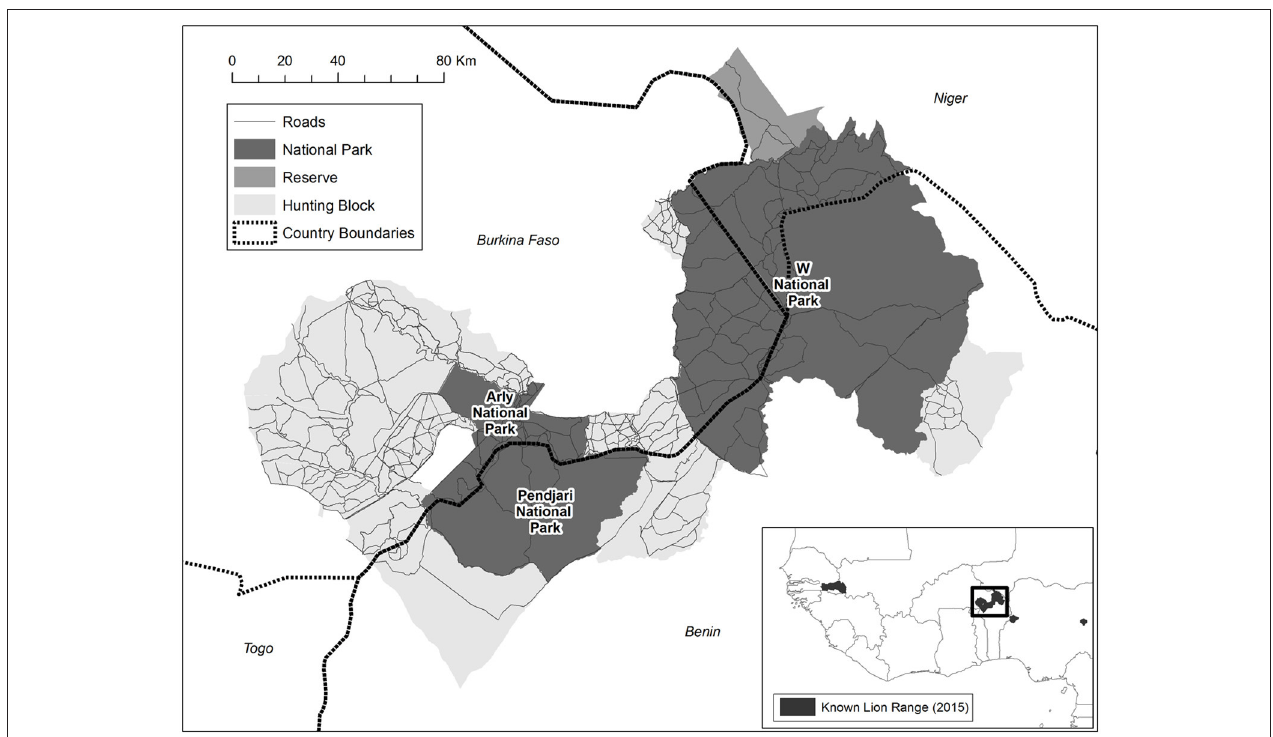
FIGURE 1 | W-Arly-Pendjari (WAP), located in the border region of Benin, Burkina Faso and Niger, and representing an area of > 27,000km 2 . WAP comprises 21 discrete management blocks, including national parks (54% of land area), hunting concessions (43%) and one faunal reserve (3%). Please note that these are the 2012 management boundaries, and that the Arly NP has since almost doubled in